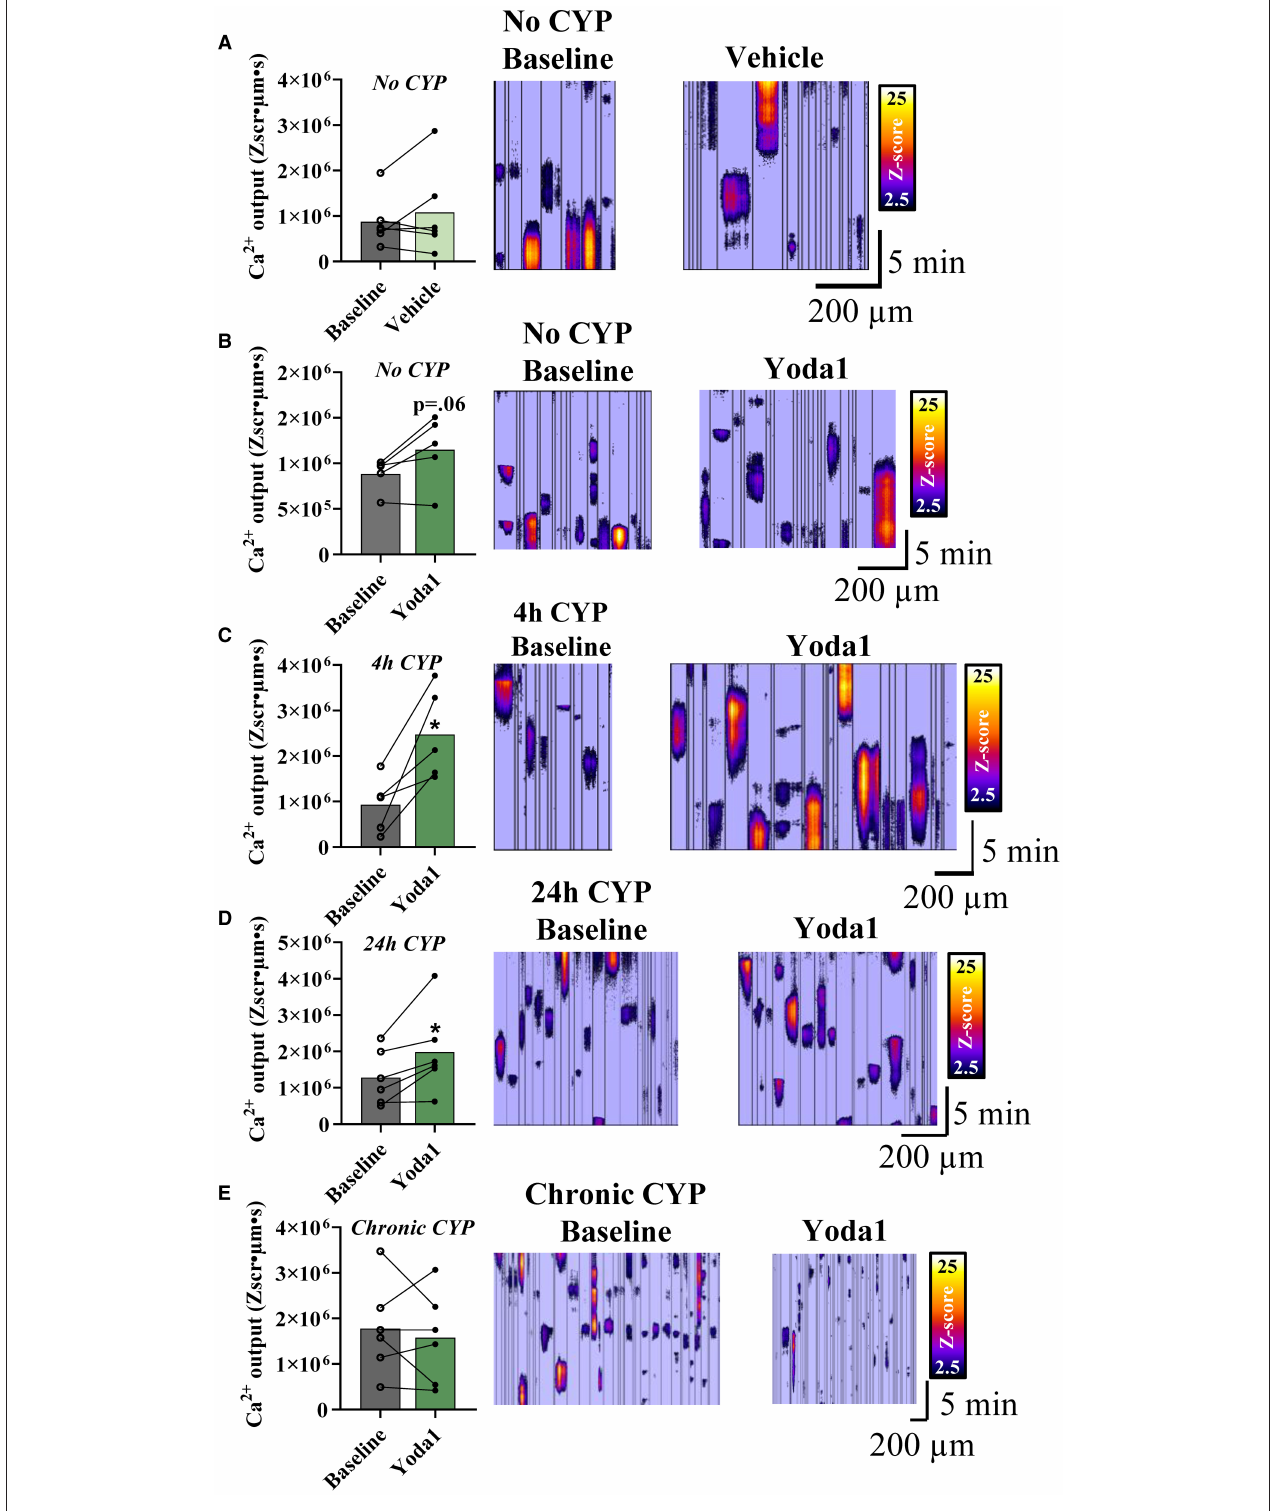
FIGURE 3 | PIEZO1 activation with Yoda1 increases Ca 2 + output in urothelial cells dependent on duration of CYP-treatment. Cells from sheets of urothelial tissue were imaged before (baseline) and after incubation with Yoda1 (20 µ M) or vehicle (0.1% DMSO). (A) Vehicle treatment ( n = 6) did not alter Ca 2 + signaling in urothelial cells compared to baseline. (B) Activation of PIEZO1 with Yoda1 in urothelial cells also did not alter Ca 2 + activity in naïve (no CYP) mice ( P = 0.06; n = 5).